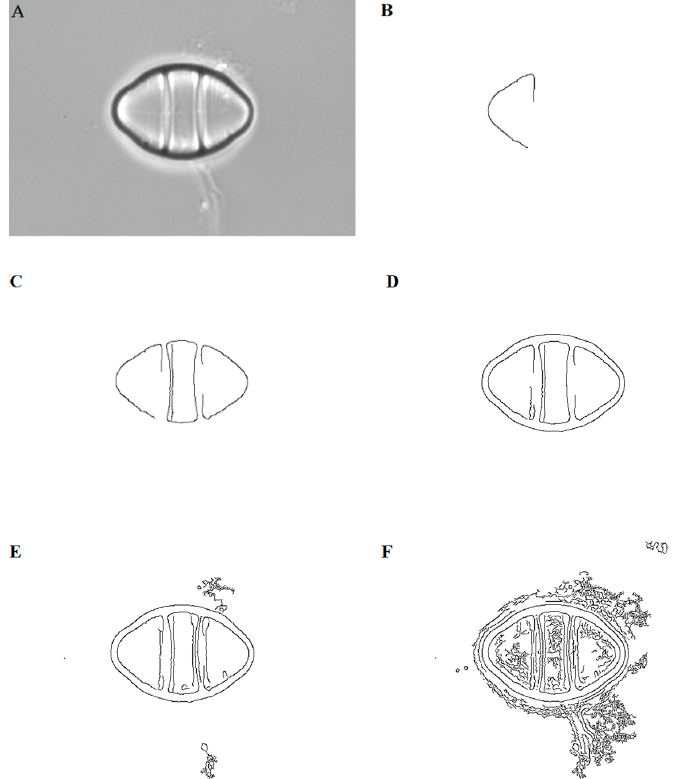
Figure 1. ( A ) Original image taken from the public data Automatic Diatom Identification and Classification (ADIAC) project. Outcomes are of the variation of a parameter (h max ) within a range of values (0, 1) with the Canny edge detector, where results move from under-segmented images ( B , C ) to over-segmented ones ( E , F ), passing through an intermediate value where the best possible result is obtained ( D ).